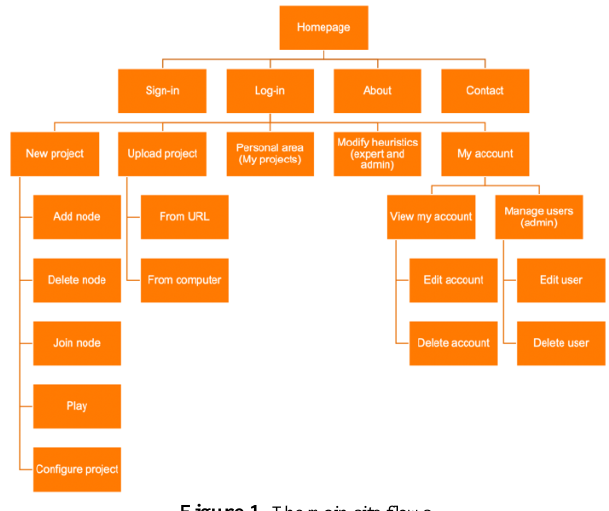
Figure 1. The main site flows.